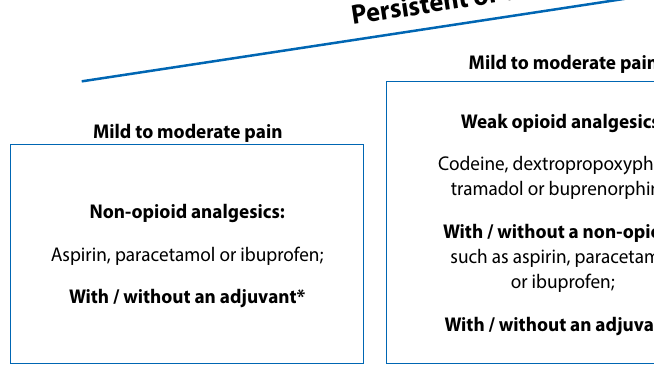
Figure 1: The World Health Organization’s three-step analgesic ladder.